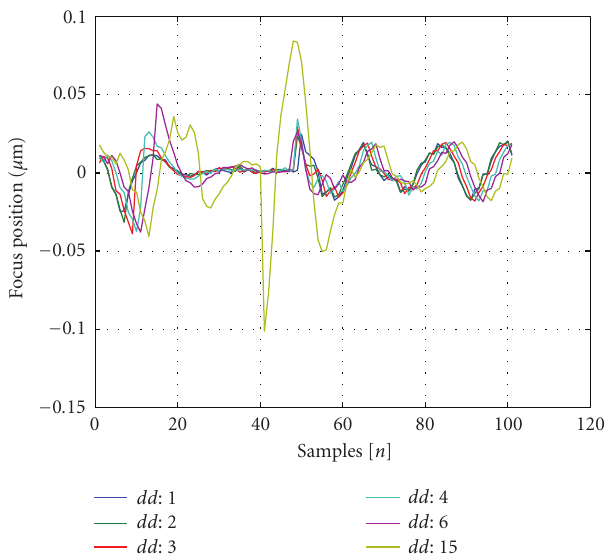
Figure 12: Simulation of the e ff ect of detection delays on the closed loop radial